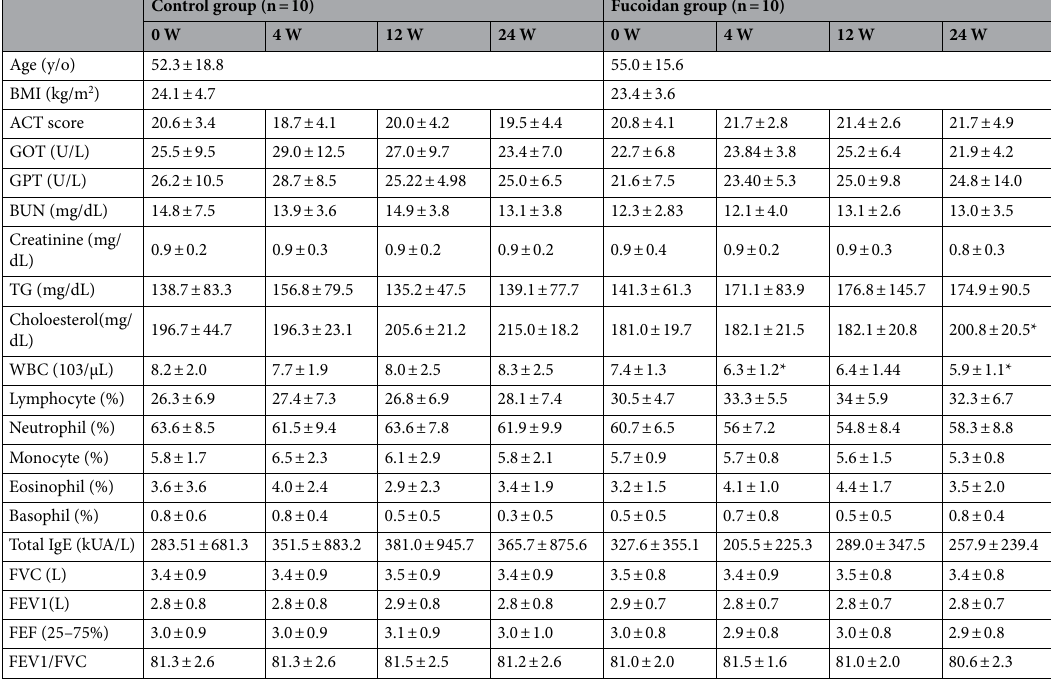
Table 1. The characteristics of subjects. *The data during 4th, 12th, 24th week (4 W, 12 W, 24 W) compared with baseline (0 W) had significant different (p < 0.05).